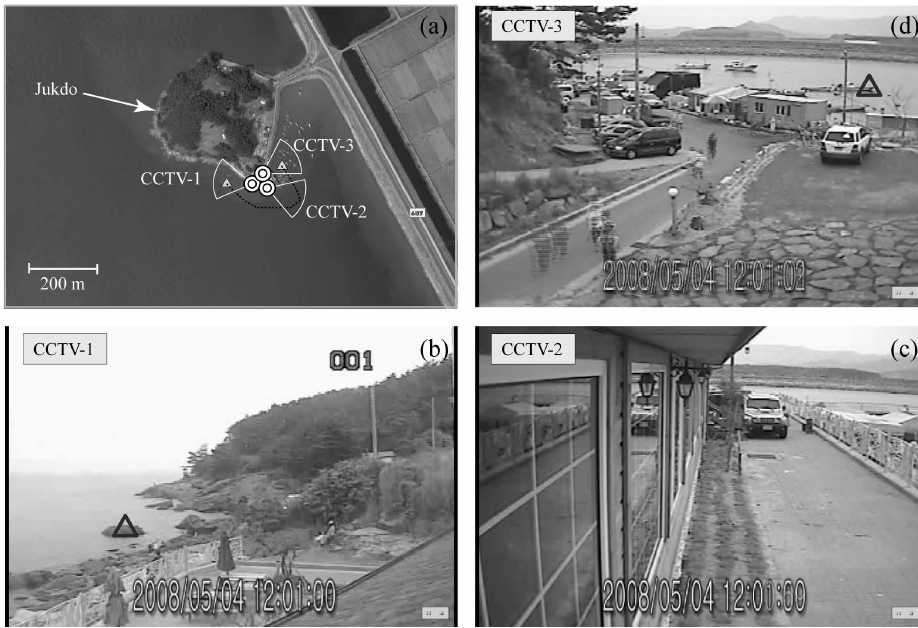
Fig. 3. (a) Location of a CCTV surveillance system deployed at the southern end of the Jukdo semi-island with three cameras facing different directions respectively. The dotted line is a path to measure a waterway distance for waves propagating between two different points (symbolized with triangles in b and d) defined in the first and third view sectors. (b) , (c) , and (d) Instantaneous snapshots from each